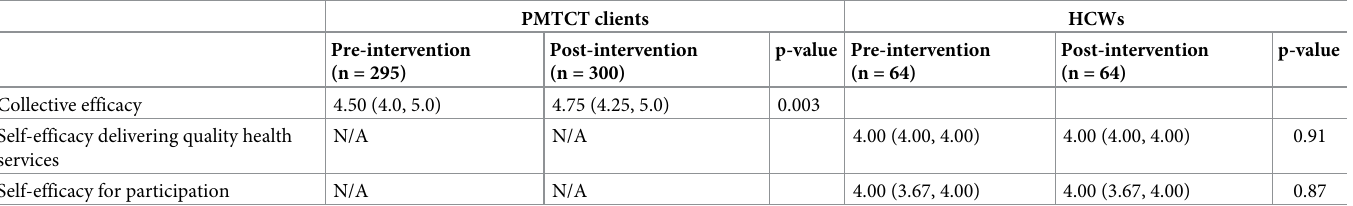
Table 5. Medians, interquartile ranges, and p-values for the measures of collective efficacy for the PMTCT clients, and self-efficacy delivering quality health service for participation for HCWs, pre and post intervention.